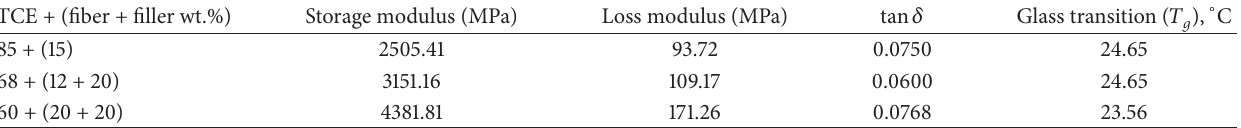
Table 5: Dynamic mechanical properties of TCE + PTFE filled hybrid